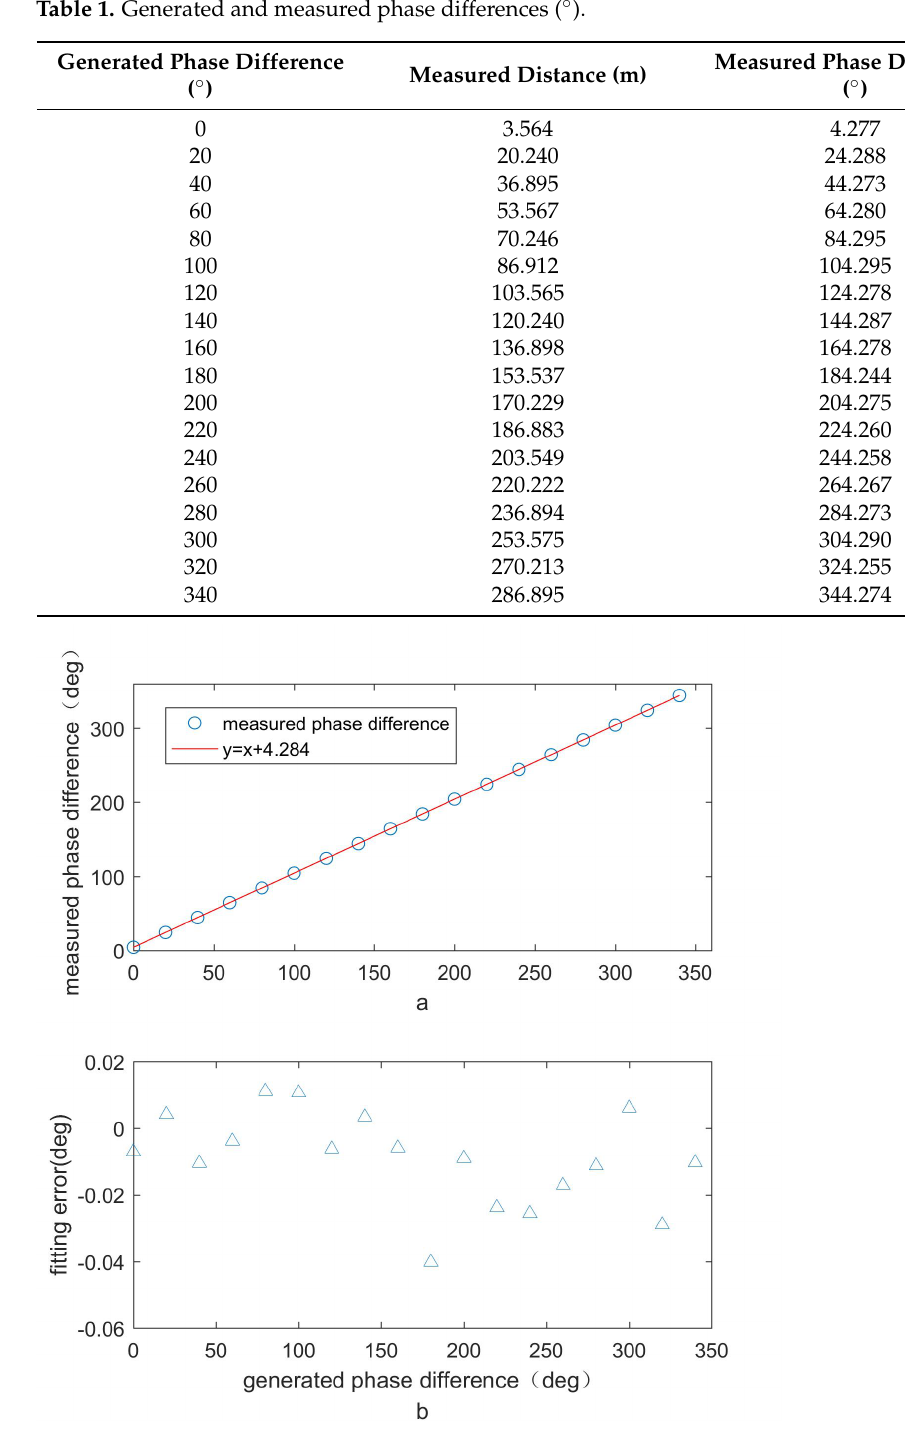
Figure 9. Variation of the ( a ) measured phase difference @500 kHz and ( b ) fitting error with the generated phase